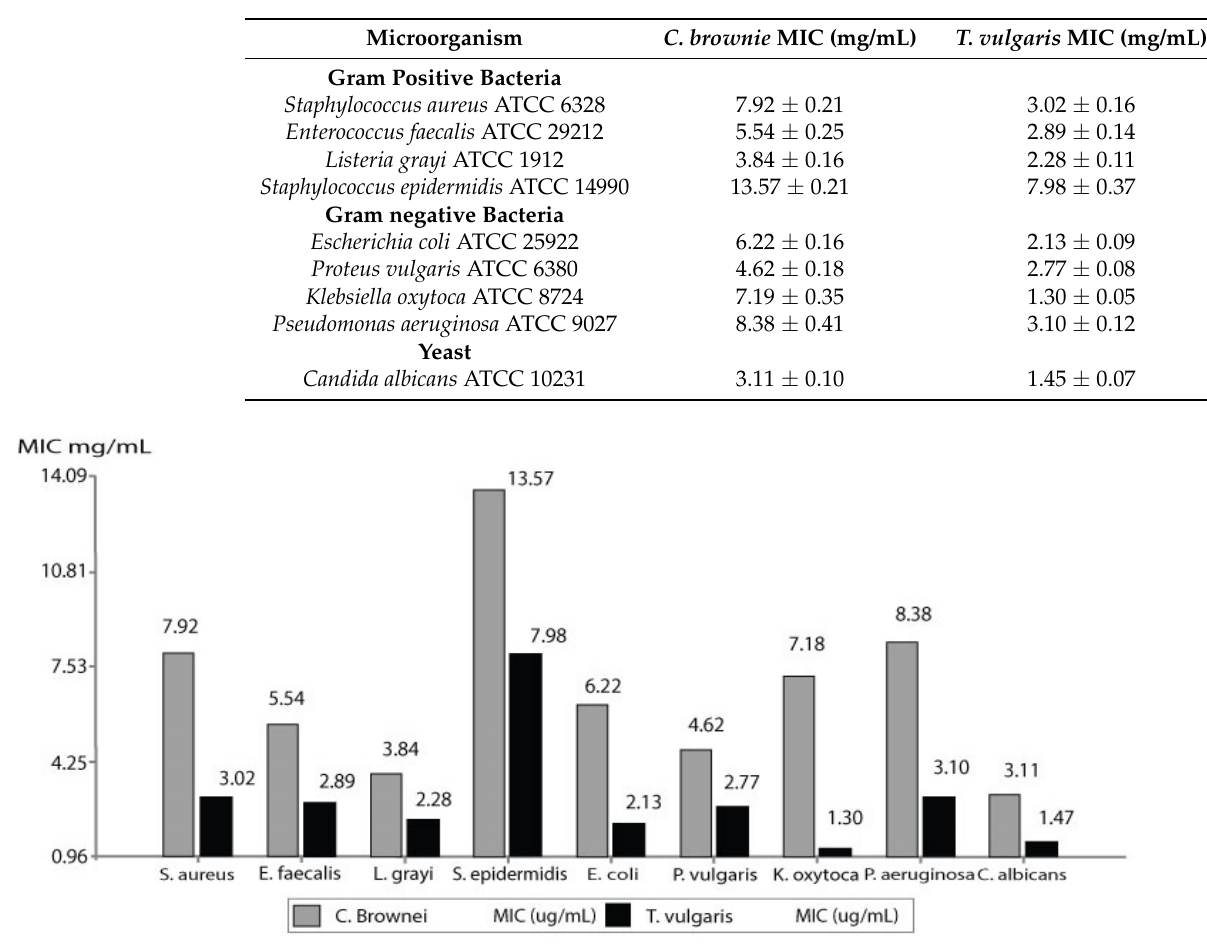
Figure 1. DPPH Bioautographic assay of Clinopodium brownei essential oil, bioactive molecules: Rf 0.633 methyl cinnamate, Rf 0.709 ethyl cinnamate and Rf 0.937 caryophyllene. Table 3. MIC values of C. brownei essential oil and T. vulgaris essential oil (natural control) [22] on various microorganisms. Mean ± SD ( n = 4), p < 0.05.